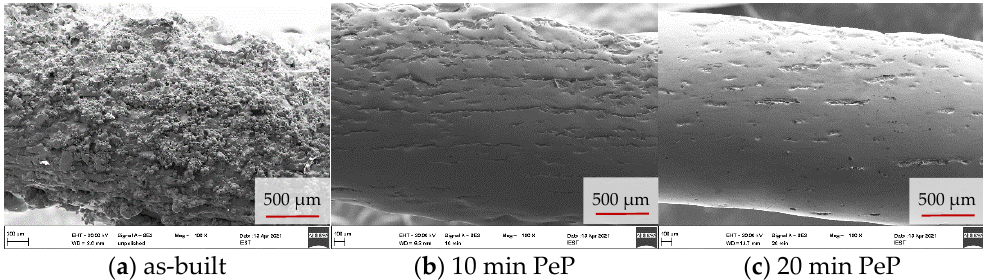
Figure 6. SEM overview images of the lateral spring surface after different PeP times.